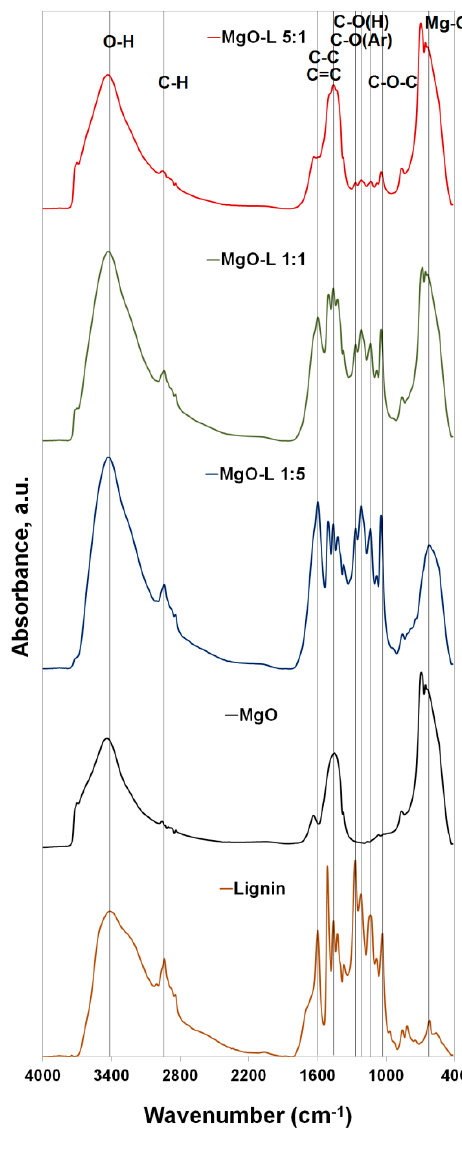
Figure 1. Fourier transform infrared (FTIR) spectra of MgO, lignin and MgO–lignin hybrid materials with di ff erent ratio of individual components.